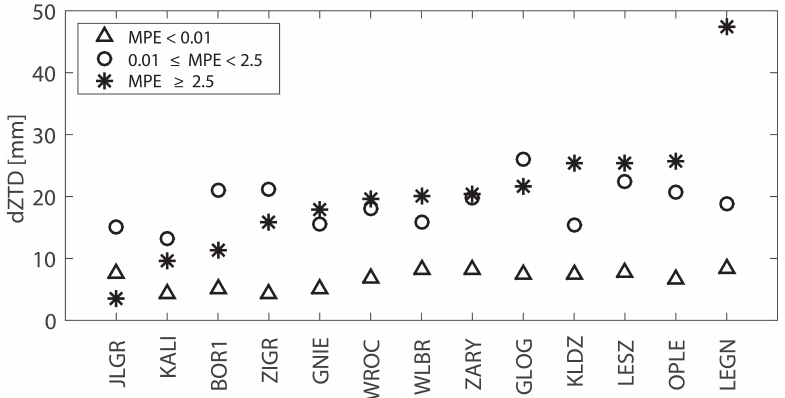
Figure 12. dZTD averaged in 56 days at 13 GNSS stations with respect to MPE parameter. Stars correspond to high precipitation events (MPE ≥ 2.5 mm/h), circles show moderate rain intensity (0.01 ≤ MPE < 2.5 mm/h) and triangles refer to negligible precipitation (MPE < 0.01